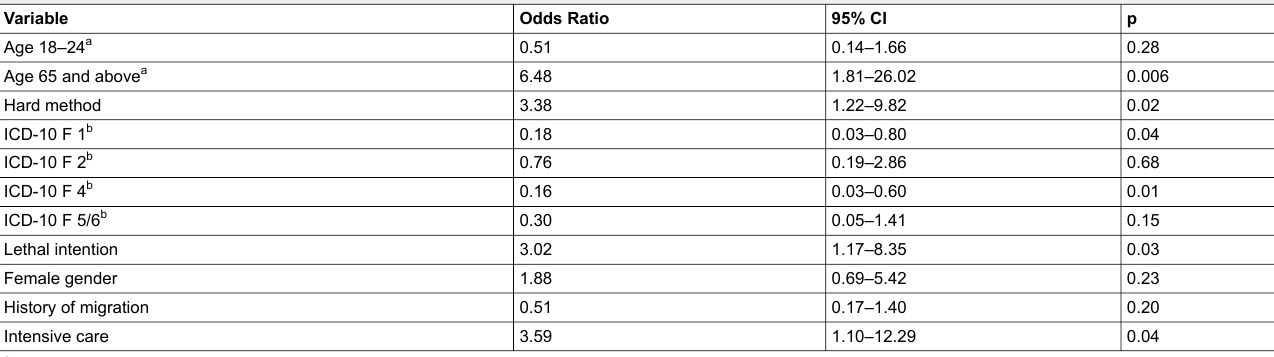
Table 5: Results of multiple logistic regression for high-cost case as outcome (n = 161, pseudo-R 2 = 0.373). Variable Odds Ratio 95% CI